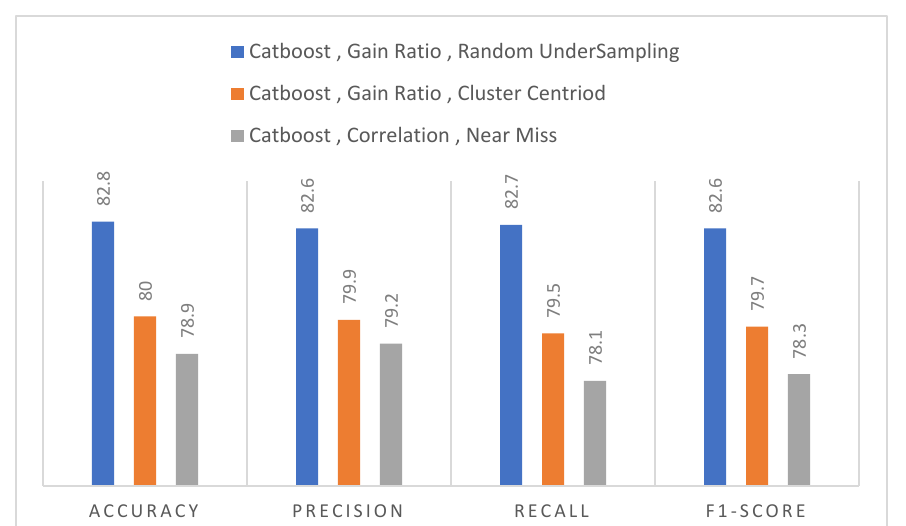
Figure 3. Result of CatBoost models to feature selection undersampling technique. Table 6. Results of Cluster Centroid to each feature selection technique.